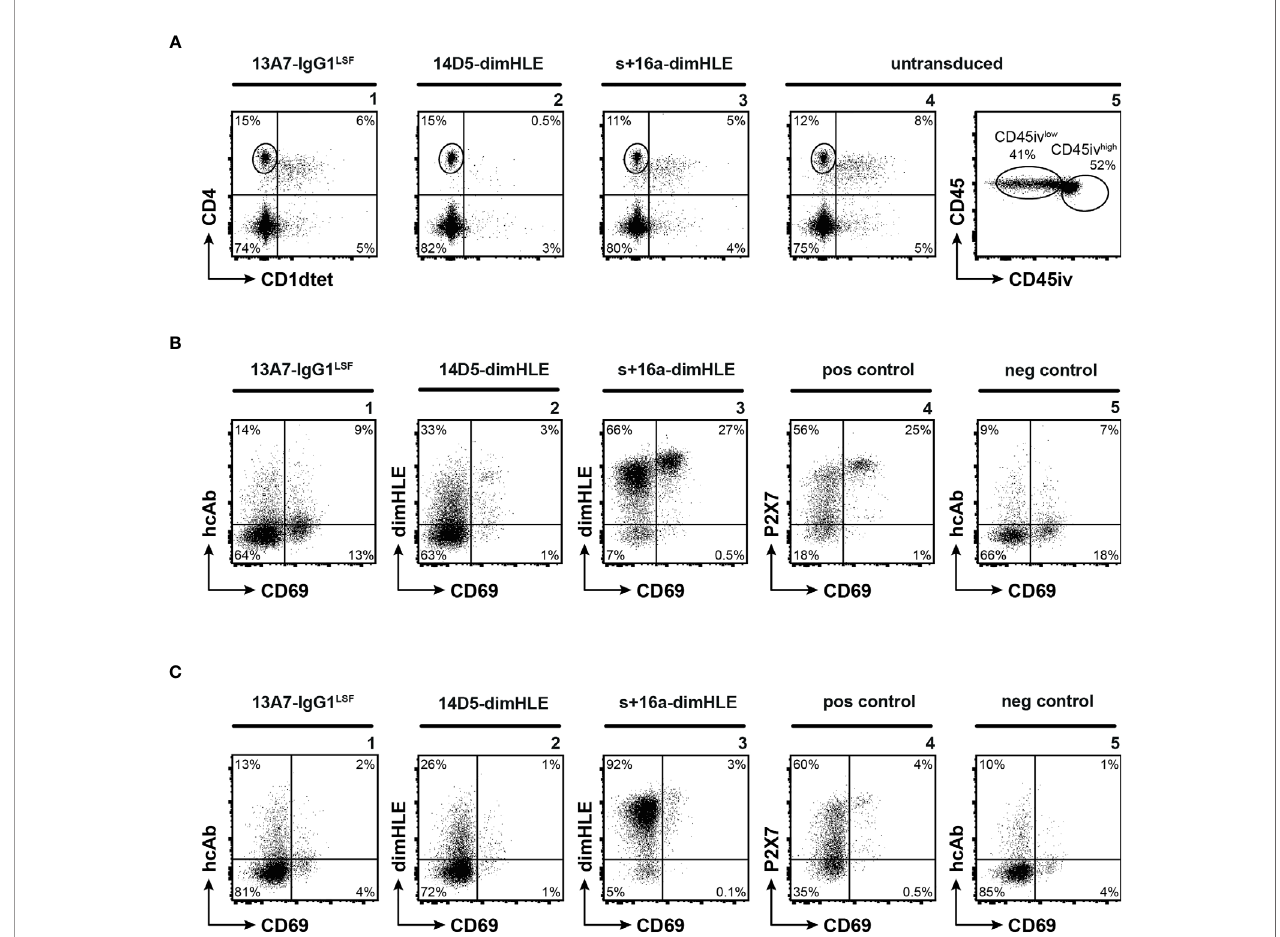
FIGURE 4 | Nanobody-based biologics produced in vivo following rAAV injection reach ARTC2.2 and P2X7 expressed at high levels by T RM located in the liver parenchyma. C57BL/6 mice were injected i.m. with rAAV1 encoding P2X7-blocking 13A7-IgG1 LSF hcAb, P2X7-potentiating 14D5-dimHLE, or ARTC2.2-blocking s+16a-dimHLE, or with PBS (untransduced). 120 days after rAAV injection mice received an intravenous injection of fl uorochrome-conjugated CD45-speci fi c mAb (CD45iv) 3 min before sacri fi ce. Untransduced mice additionally received 50 µg of recombinant s+16a-dim construct 30 min before organ collection to prevent NICD and cell loss ex vivo during cell preparation, as described earlier (15, 18). Cells extracted from the liver were then counterstained with mAbs directed against CD45, CD4, and CD69 (i.e., a marker of tissue resident lymphocytes) and with a CD1d-tetramer (CD1dtet) loaded with a Gal/Cer (speci fi cally labels the invariant T cell receptor of NKT cells). (A) Representative fl ow cytometry plots illustrating liver CD4 + T cells and CD4 + CD1dtet + NKT cells (panels 1-4), and the gating of parenchymal (CD45iv low ) and vascular (CD45iv high ) CD4 + CD1dtet - lymphocytes (panel 5). (B, C) Representative fl ow cytometry plots illustrating the detection of the nanobody-based constructs on the cell surface of tissue resident CD45iv low (B) and vascular CD45iv high (C) CD4 + CD1dtet - T cells. To detect cell surface bound dimHLE constructs, cells were stained with Alb8-speci fi c mAb77 (mouse IgG1) followed by an mIgG1-speci fi c secondary mAb. To detect cell surface bound 13A7- IgG1 LSF , cells were stained directly with the secondary mIgG1-speci fi c mAb. Positive (pos) control staining was performed with liver cells from untransduced mice using the P2X7-speci fi c 13A7-dimHLE, mAb77, and the mIgG1-speci fi c secondary mAb. Negative (neg) control staining was performed with the secondary detection reagents alone. Numbers indicate the percentages of cells in the respective quadrants or gates ( A , panel 5). Staining was performed using fl uorochrome conjugated antibodies speci fi c to CD45 (coupled to PerCP-Cy5.5 for the one injected i.v. and to AF700 for the one added in vitro ), CD4 (APC), CD69 (FITC), mouse IgG1 (BV421) and CD1dtet (coupled to